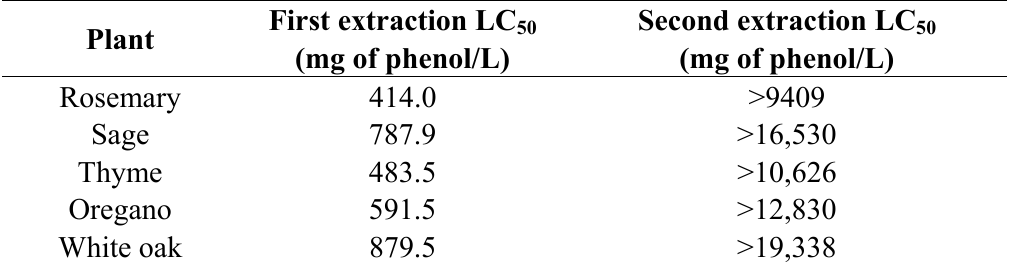
Table 4. Extraction effectiveness of ethyl acetate, ethyl alcohol, and water in the volume ratio of 4.5:4.5:1 on